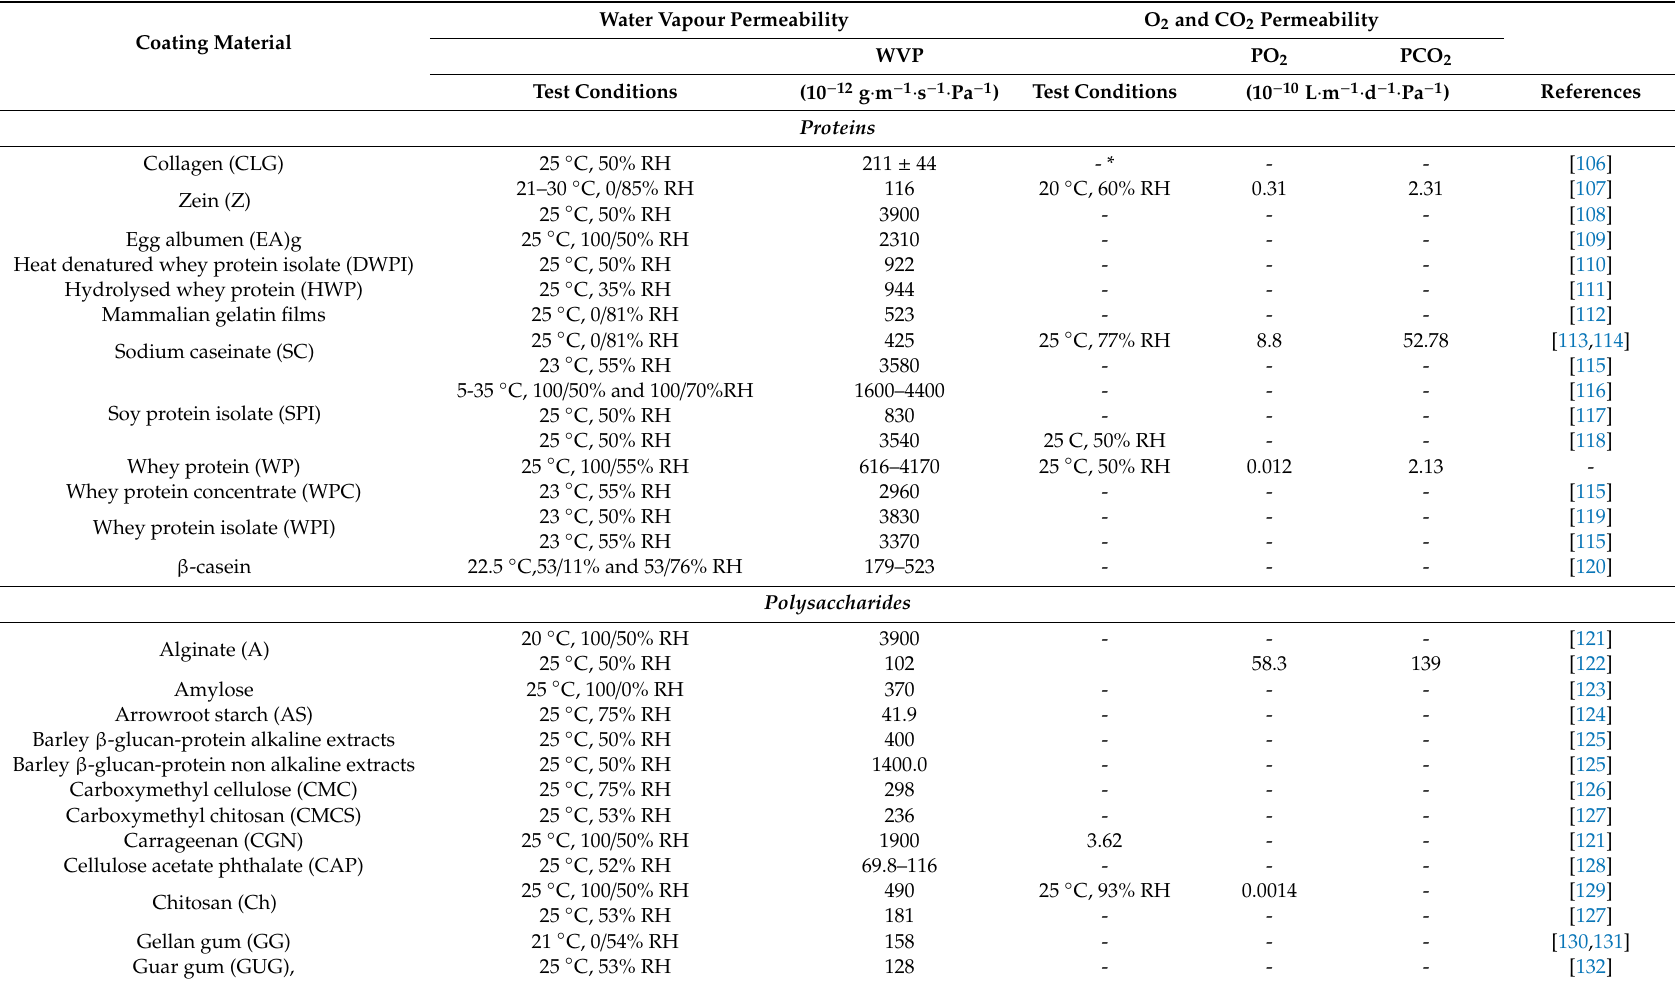
Table 2. Di ff erent works reporting the water vapor, O 2 , and CO 2 permeability of some edible